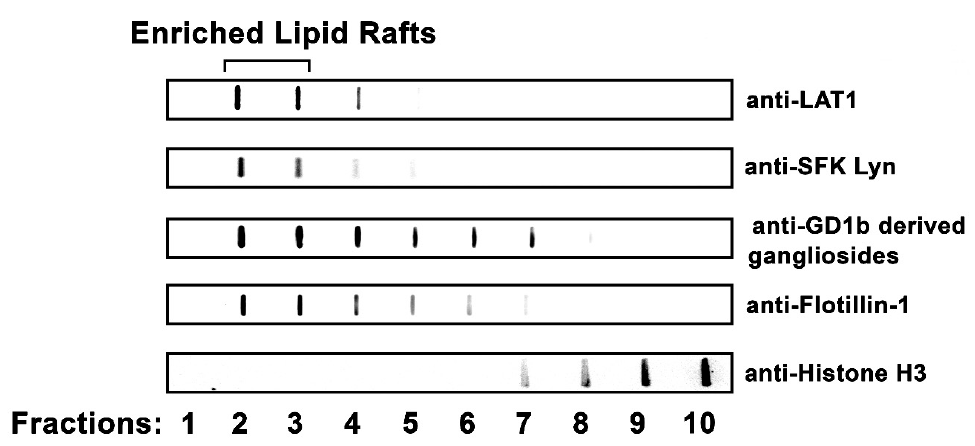
Figure 1. Identification of RBL-2H3 mast cell lipid rafts. Lysates of RBL-2H3 MCs were fractionated using sucrose density gradient ultracentrifugation, and fractions were immunoblotted using antibodies against lipid raft markers: LAT1, SFK Lyn, rodent MC-specific GD1b-derived gangliosides, and Flotillin-1. Proteins and lipids associated with lipid rafts were concentrated in Fractions 2 and 3. Fractions were also immunoblotted with anti-Histone H3, a nuclear protein. Data representative of three independent experiments is shown.